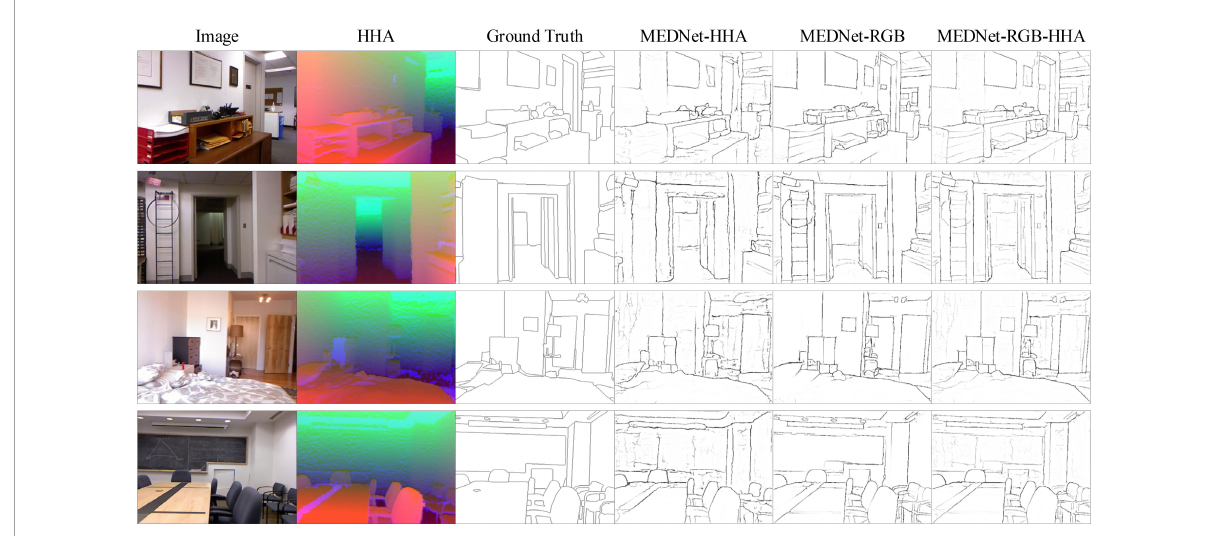
FIGURE9 Partial test results of the proposed method on NYUD-V2 data set are presented. Source photos: BSDS500 dataset - publicly available dataset.